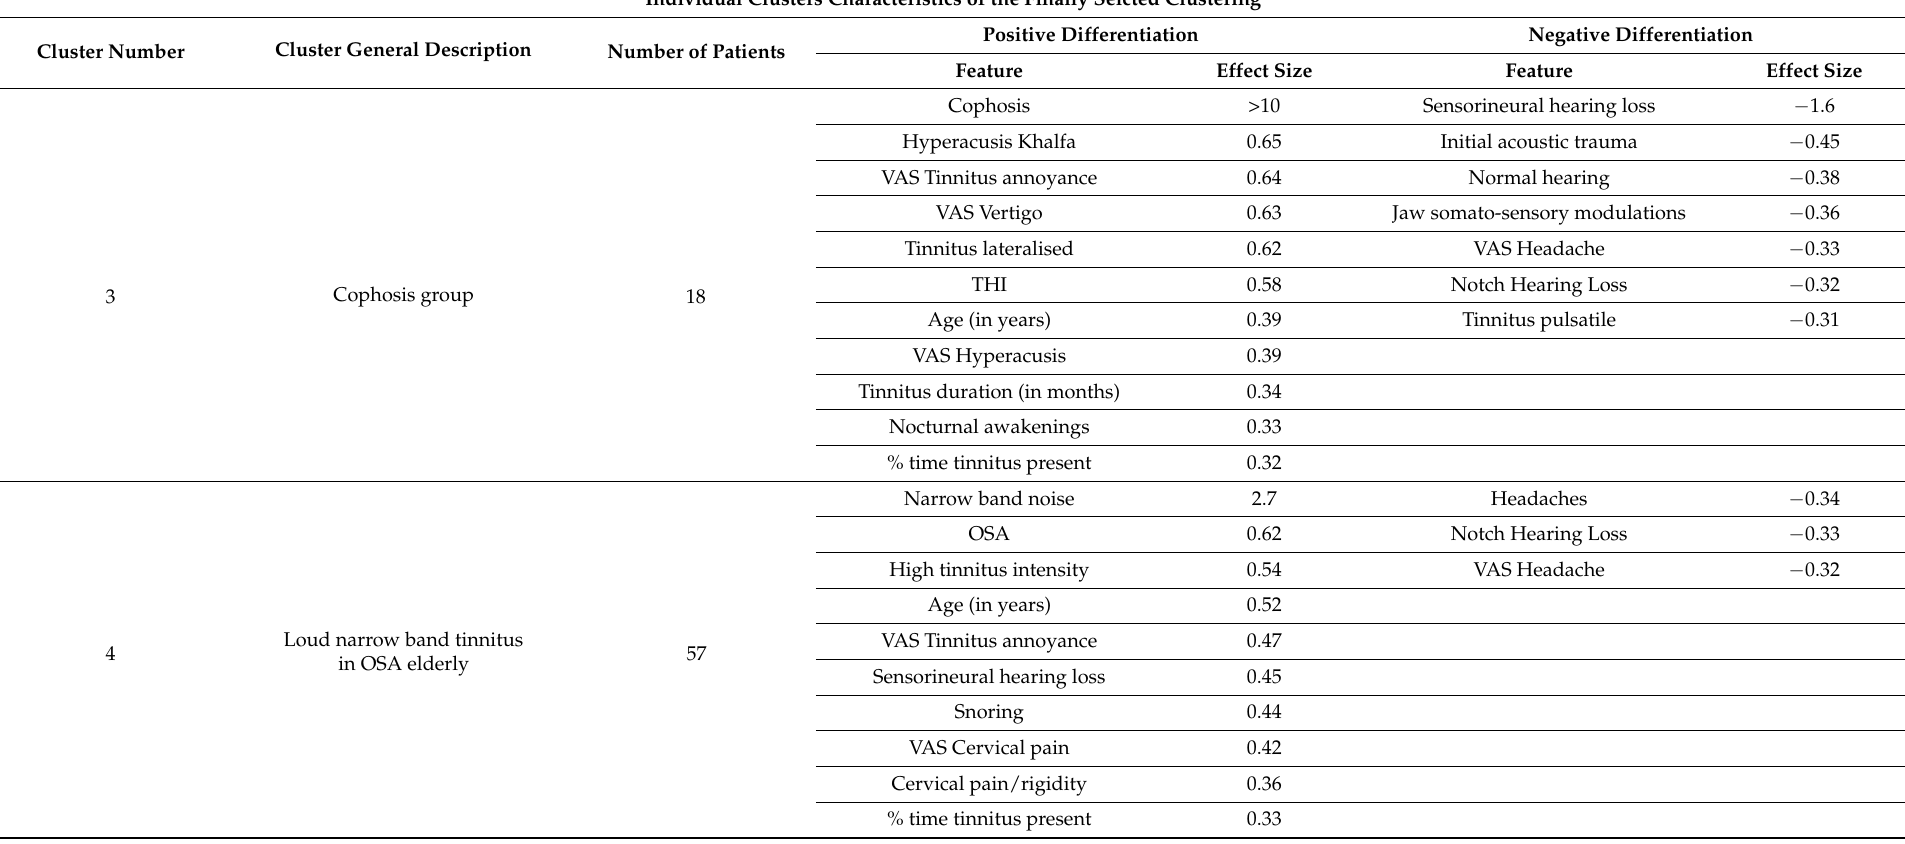
Table 7. Cont. Individual Clusters Characteristics of the Finally Selcted